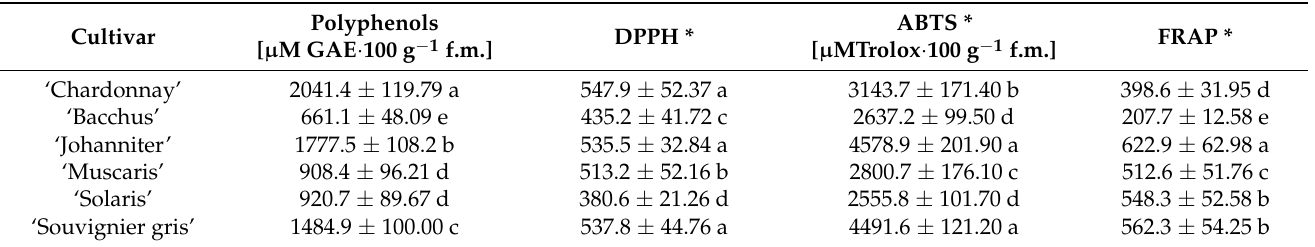
Table 3. Total polyphenol content and antioxidant activity of six cultivars of white whole grape berries. Cultivar